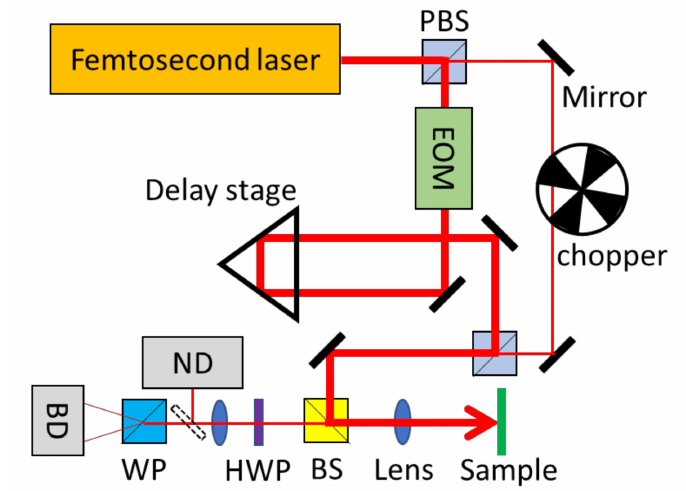
Figure 2. The pump-probe experimental set-up. A pulsed laser was split to the pump (thick red line) and probe (thin red line) via a polarizing beam splitter (PBS). The pump and probe were modulated via an electro-optic modulator (EOM) and optical chopper, respectively. The time delay between the pump and probe was controlled by a delay stage. The pump and probe were focused on the transducer surface by a lens. The reflection from the probe, after the non-polarizing beam splitter (BS), was collected by a normal detector (ND) for ∆ R measurement and by a balanced detector (BD) for ∆ θ measurement. For ∆ θ measurement, a halfwave plate (HWP) and Wollaston prism (WP) were used to control the polarization of the probe beam.